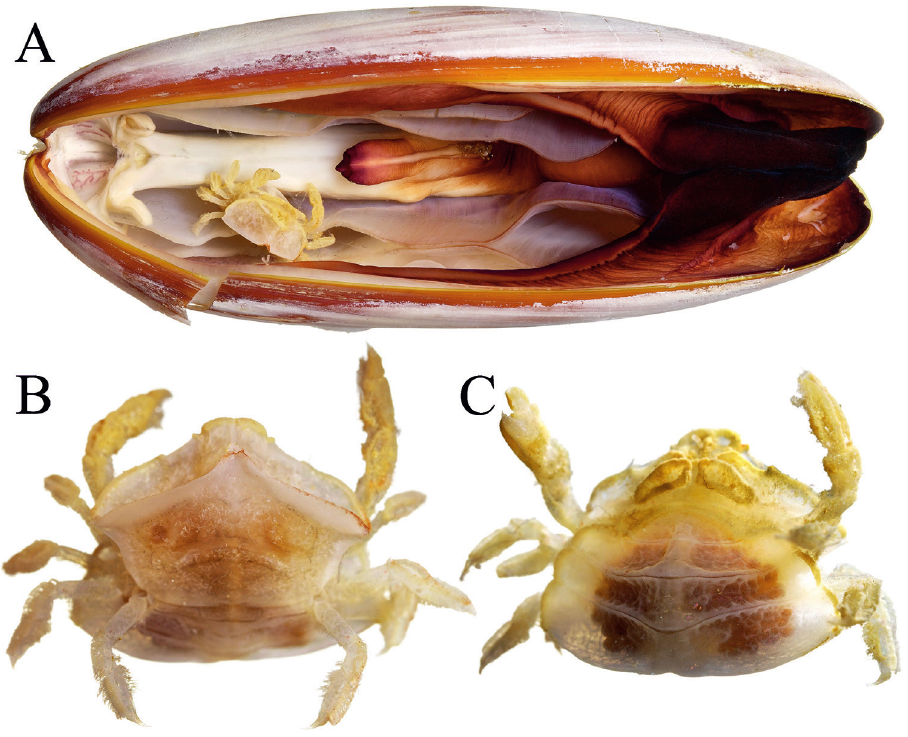
Figure 1. Colour in life. Serenotheres janus sp. n., holotype ♀ (8.9 × 7.9 mm) (USNM). A in situ in host date mussel, Leiosolenus obesus B dorsal view C ventral view. Photographs courtesy of Zachariah Kobrinsky and David